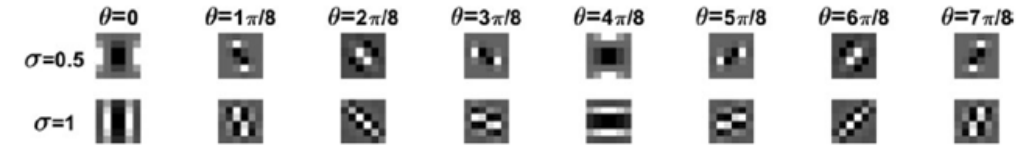
Figure 5. Sixteen 6 × 6 Gabor filters with different orientations and scales